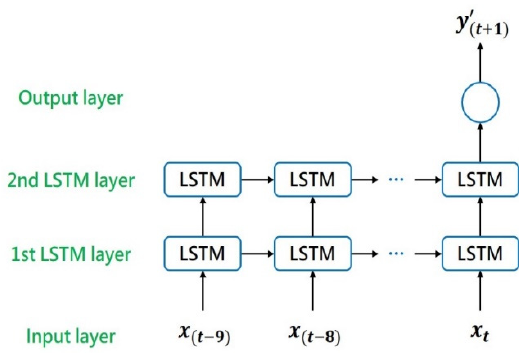
Figure 2. LSTM model with the many-to-one structure.